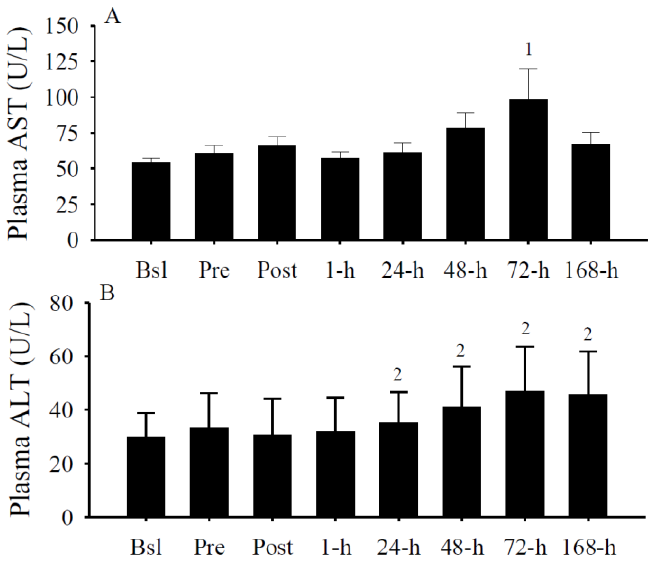
Figure 5. Plasma aspartate aminotransferase (AST) (U/L) and ALT (U/L) concentrations. ( A ) Plasma AST was significantly increased at 72-h ( 1 p < 0.05 vs. Bsl). ( B ) Plasma ALT was significantly ( 2 p < 0.05 vs. Post) increased at 24-h, 72-h, and 168-h. Data presented as mean ± SEM.